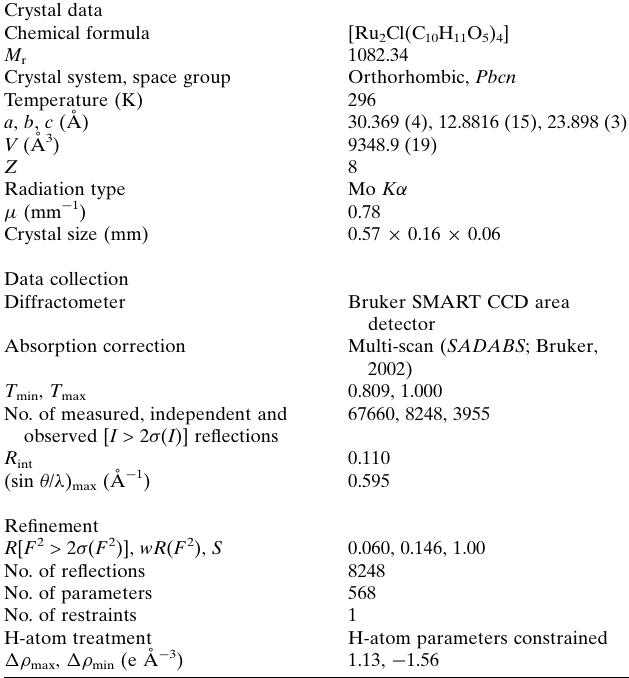
Table 2 Experimental details. Crystal data Chemical